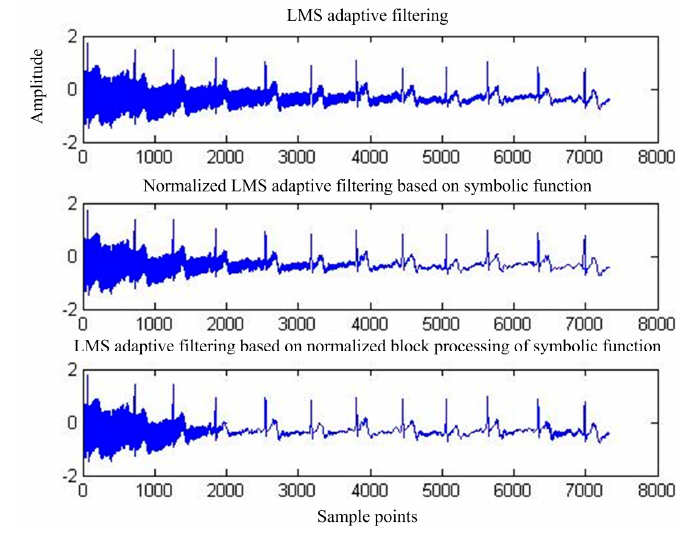
Figure 11. Output of the three adaptive interference cancellation algorithms.